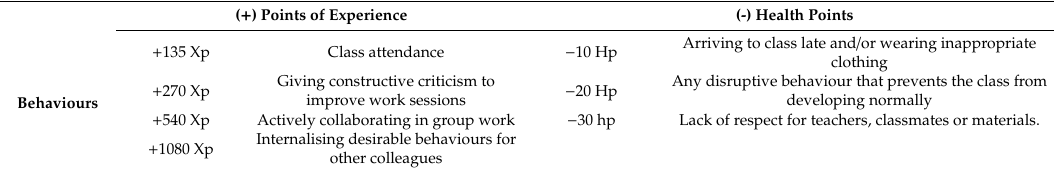
Table 3. Equivalences between behaviours and gamified points.